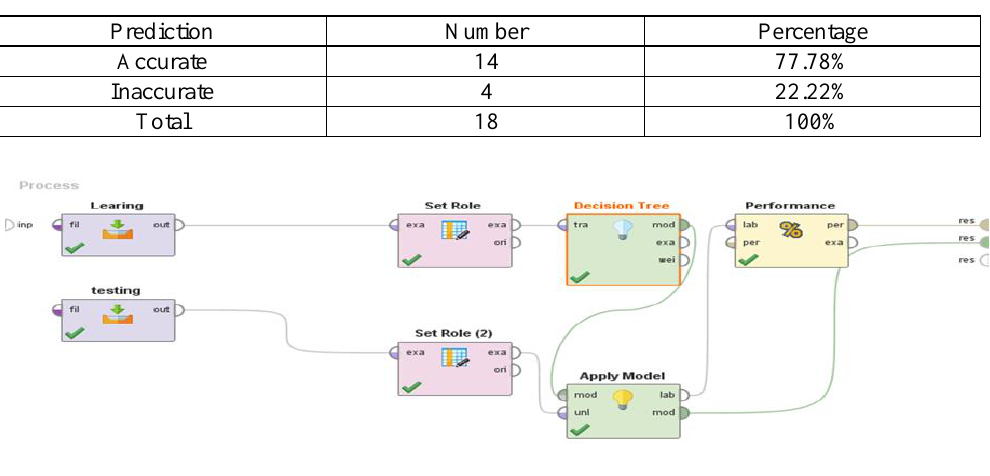
Figure.3. C4.5 Decision Tree